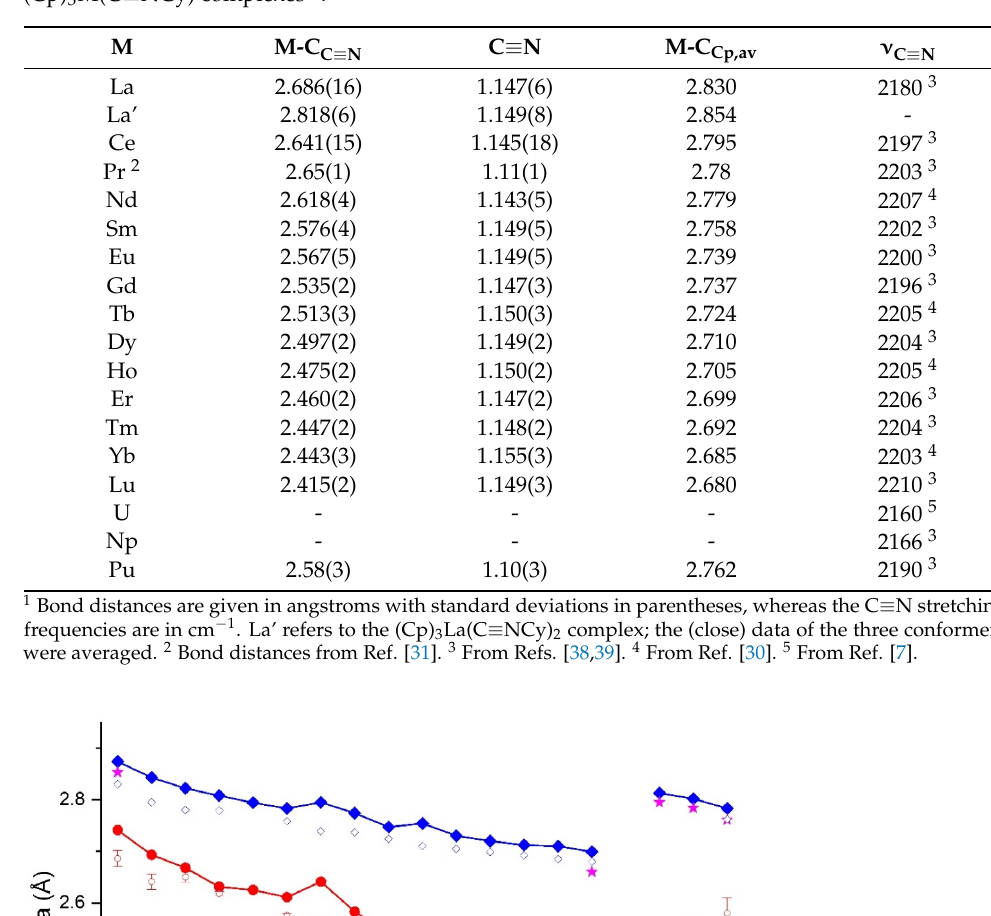
Table 1. Selected experimental data: bond distances and C ≡ N stretching frequencies of (Cp) 3 M(C ≡ NCy) complexes 1 .